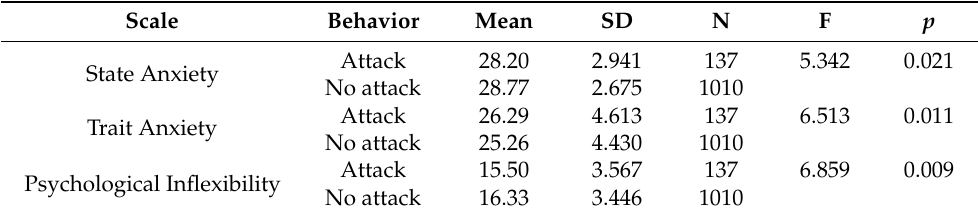
Table 3. Differences in aggressive behaviors depending on the state anxiety, trait anxiety, and psychological inflexibility of